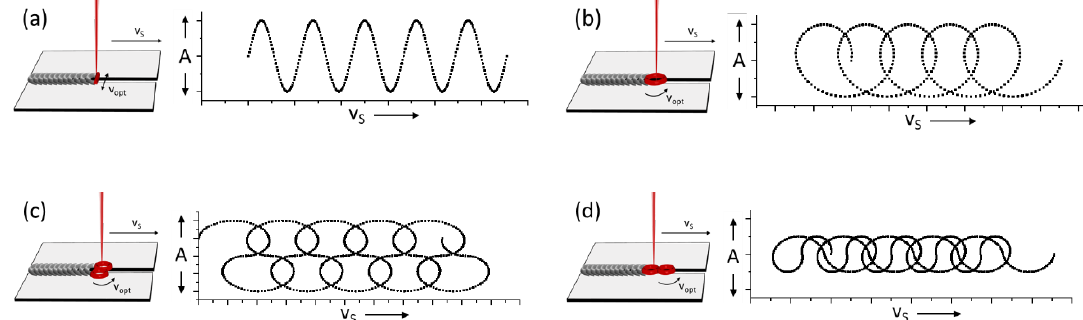
Figure 6. Schematic trajectory of the welding path for oscillation patterns: line ( a ), circle ( b ), eight frame crosswise ( c ) and eight frame lengthwise ( d ).